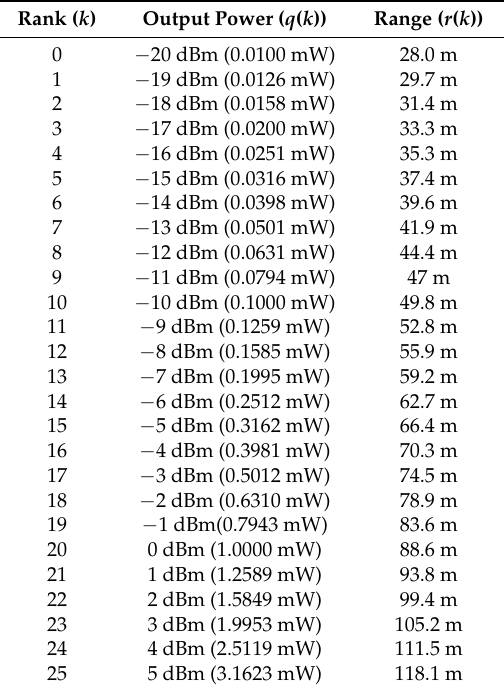
Table 2. The transmit range with output